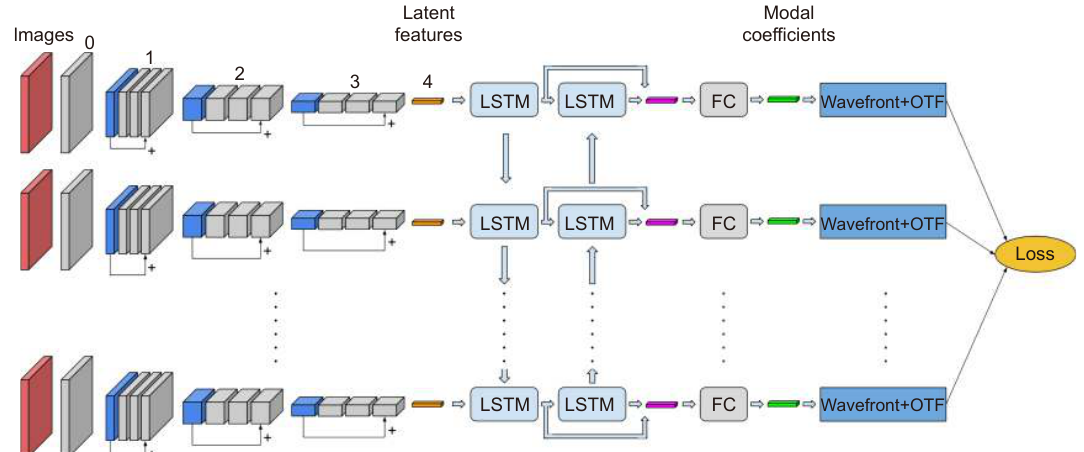
Fig. 20 | Block diagrams showing the architecture of the network and how it is trained by unsupervised training. Figure reproduced from ref. 97 ,